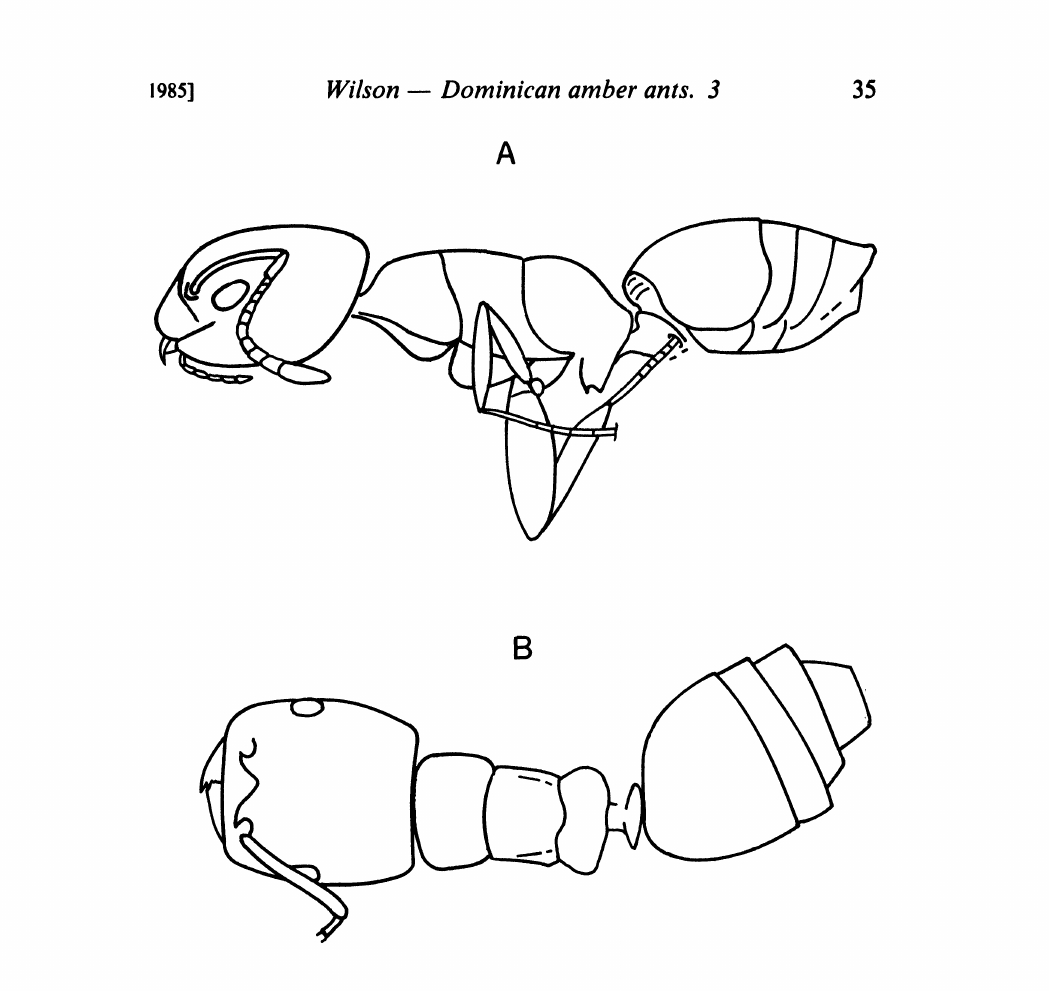
Fig. 12. Tapinoma trochis holotype worker: A, lateral view; B, dorsal